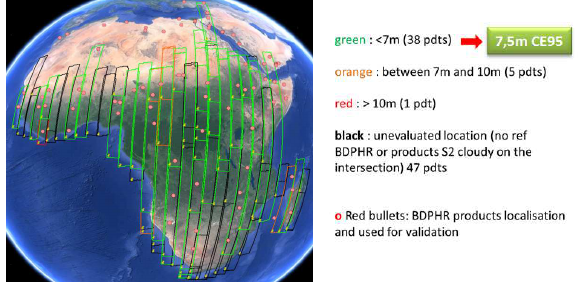
Figure 13. South Africa GRI mean geolocation